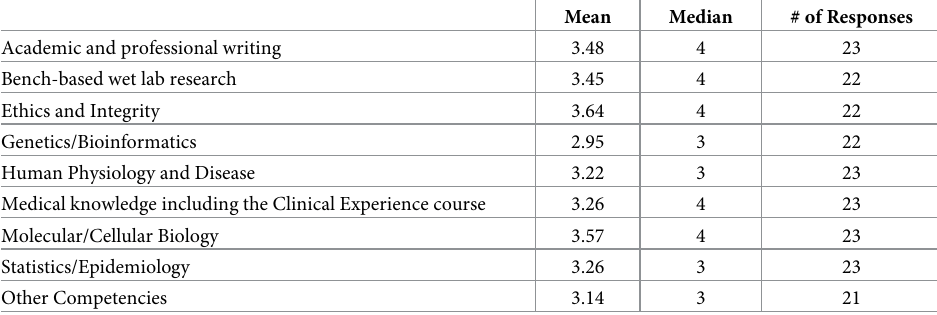
Table 5. Importance of competencies.